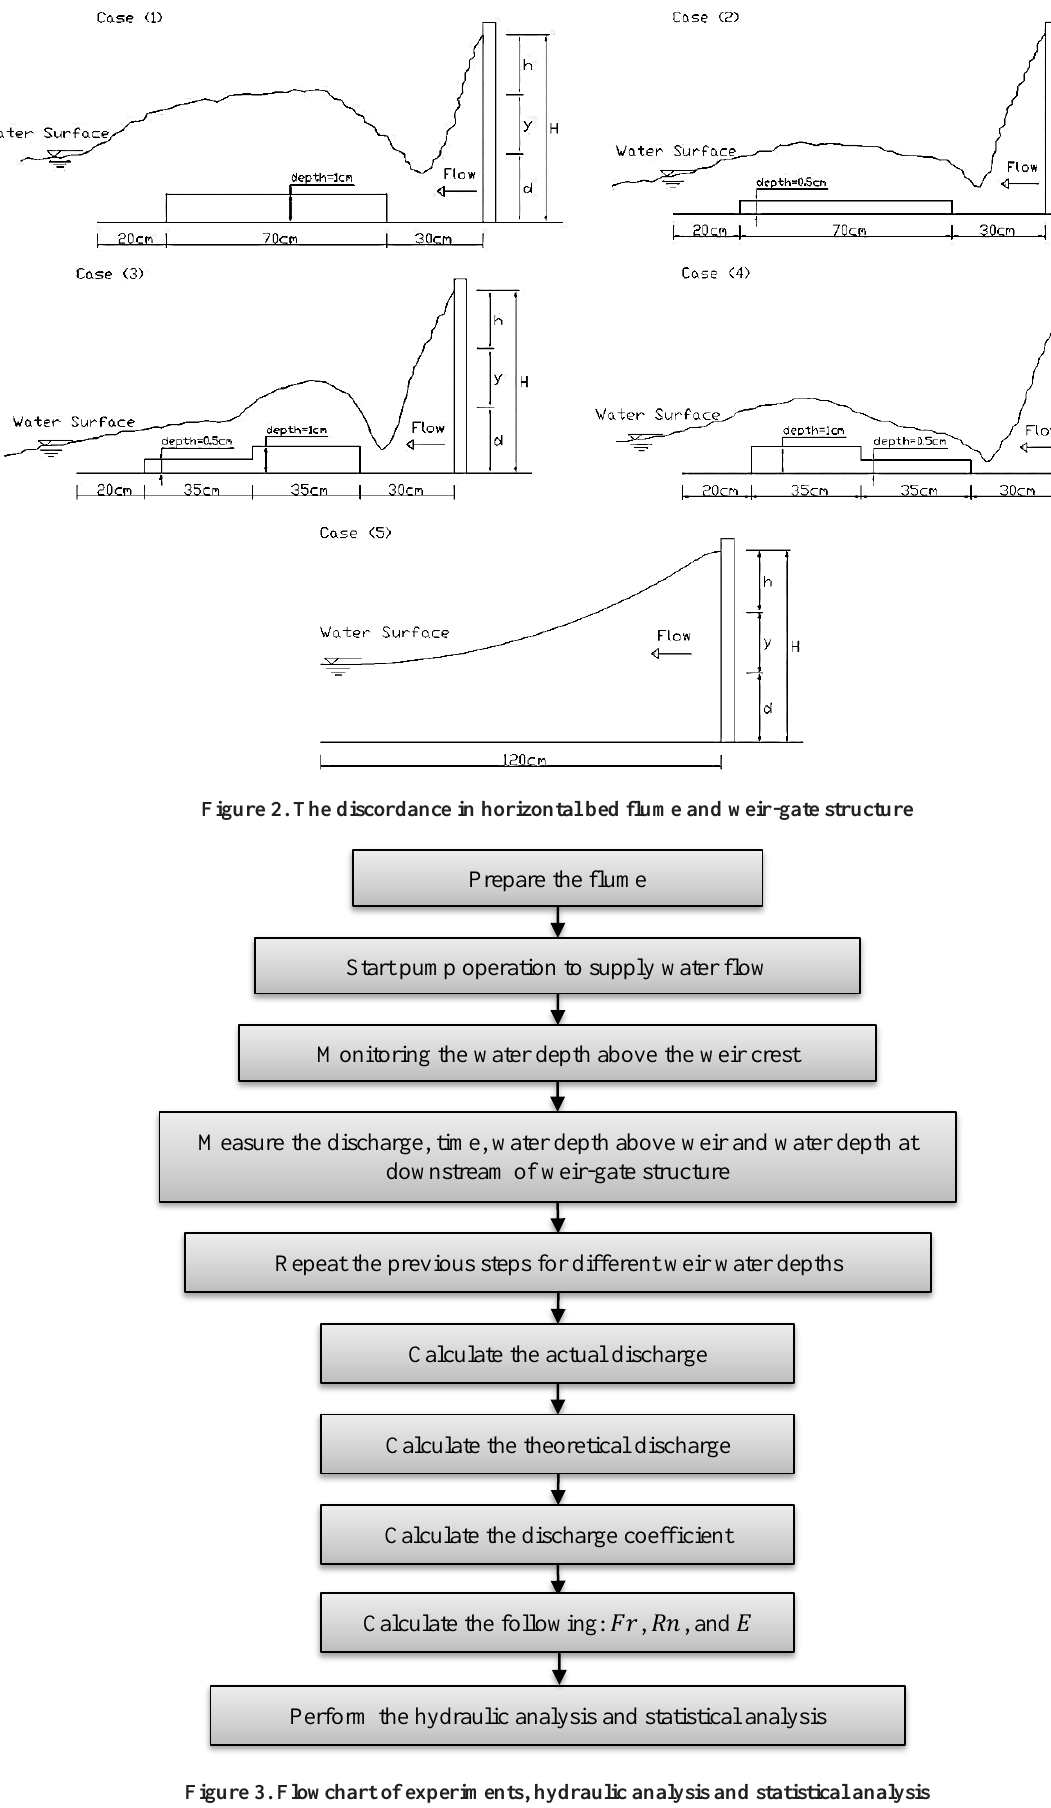
Figure 3. Flowchart of experiments, hydraulic analysis and statistical